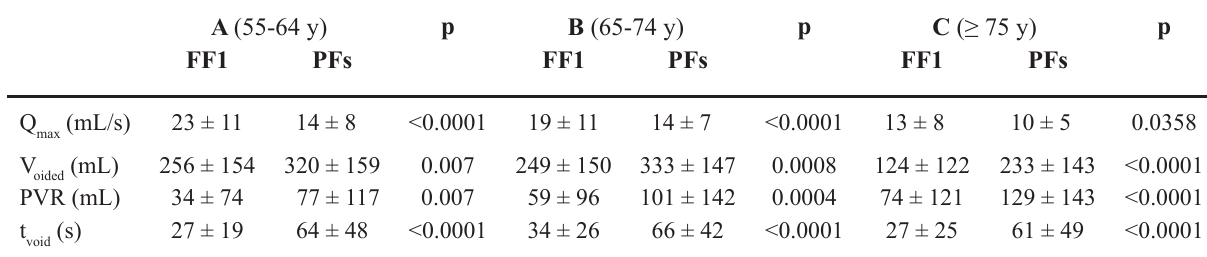
Table 4 – Changes in uroflow parameters comparing free uroflow (FF) and pressure-flow study (PFs).